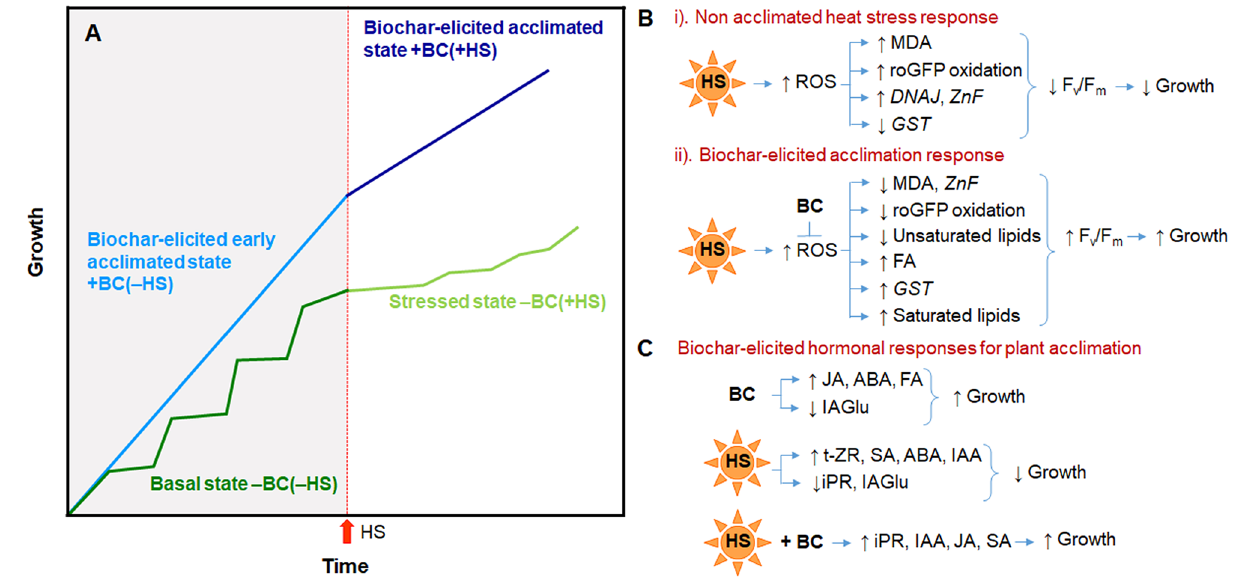
Figure 6 . Schematic depictions ( A ) of the impact of biochar on plant performance, and ( B, C ) summary of in-planta responses. ( A ) The dark green line, corresponding to the ‒ BC( ‒ HS) treatment, represents basal plant growth under the given environmental conditions. The step-wise pattern represents everyday microstresses that a plant experiences throughout its normal growth or life cycle. An acute heat stress, labeled HS, occurs at some time. Following the HS, the plant’s basal growth and development is impaired (light green line). This corresponds to the ‒ BC(+ HS) treatment. The solid light blue line represents the “biochar-elicited early acclimated state”, wherein plant growth and development is enhanced compared with the basal state, and represents the + BC( ‒ HS) condition. This state involves a boosted TCA cycle and elevated JA and ABA hormone levels. The dark blue line represents a “biochar-elicited acclimated state”, corresponding to the + BC(+ HS) condition. This state involves ROS-related oxidative stress responses. ( B, C ) In-planta responses in the